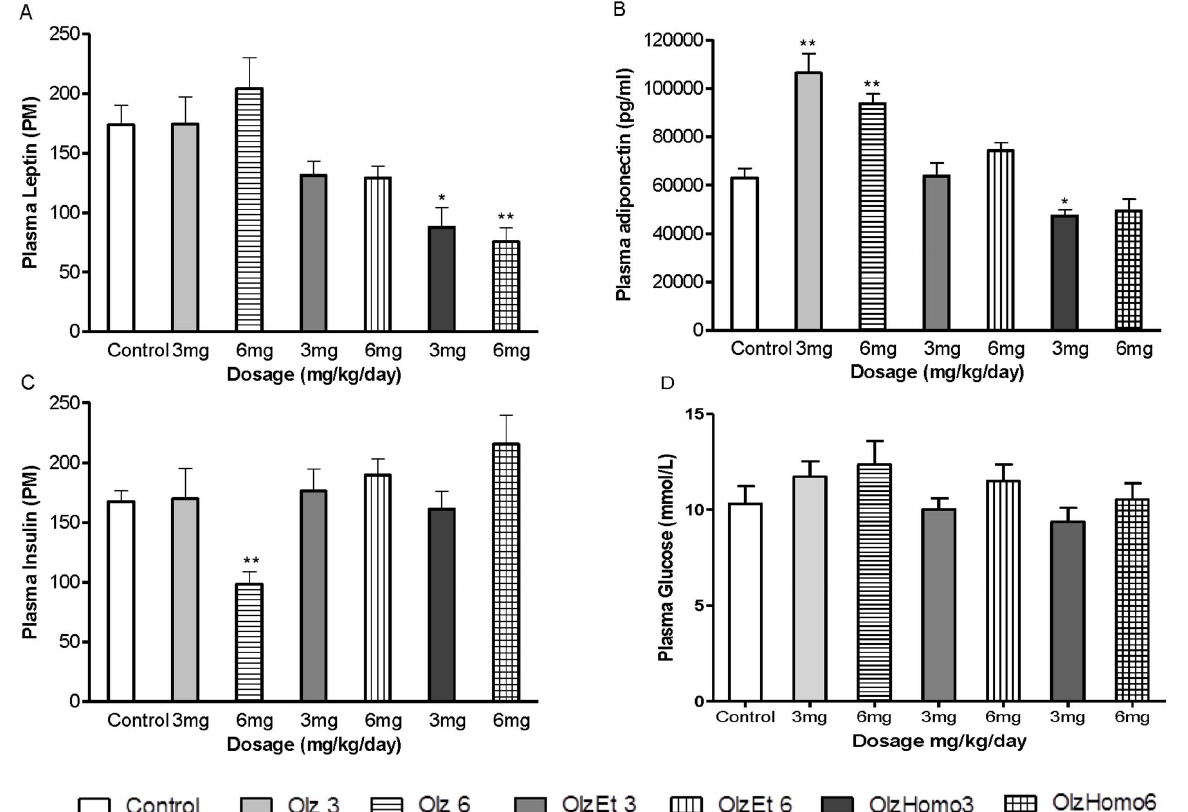
Figure 3. Hormonal profiles in female rats treated with Olz and Olz derivatives. A. Plasma Leptin (PM), B. Plasma Adiponectin (pg/ml), C. Plasma insulin (PM), D. Plasma Glucose (mmol/L) in female Sprague Dawley rats treated with Olz, OlzEt, OlzHomo (3 mg/kg or 6 mg/kg), or vehicle (Control) for 5 weeks. The data points are the mean 6 SEM, * P , 0.05 and ** P , 0.01 vs . Control. doi:10.1371/journal.pone.0080979.g003 PLOS ONE |